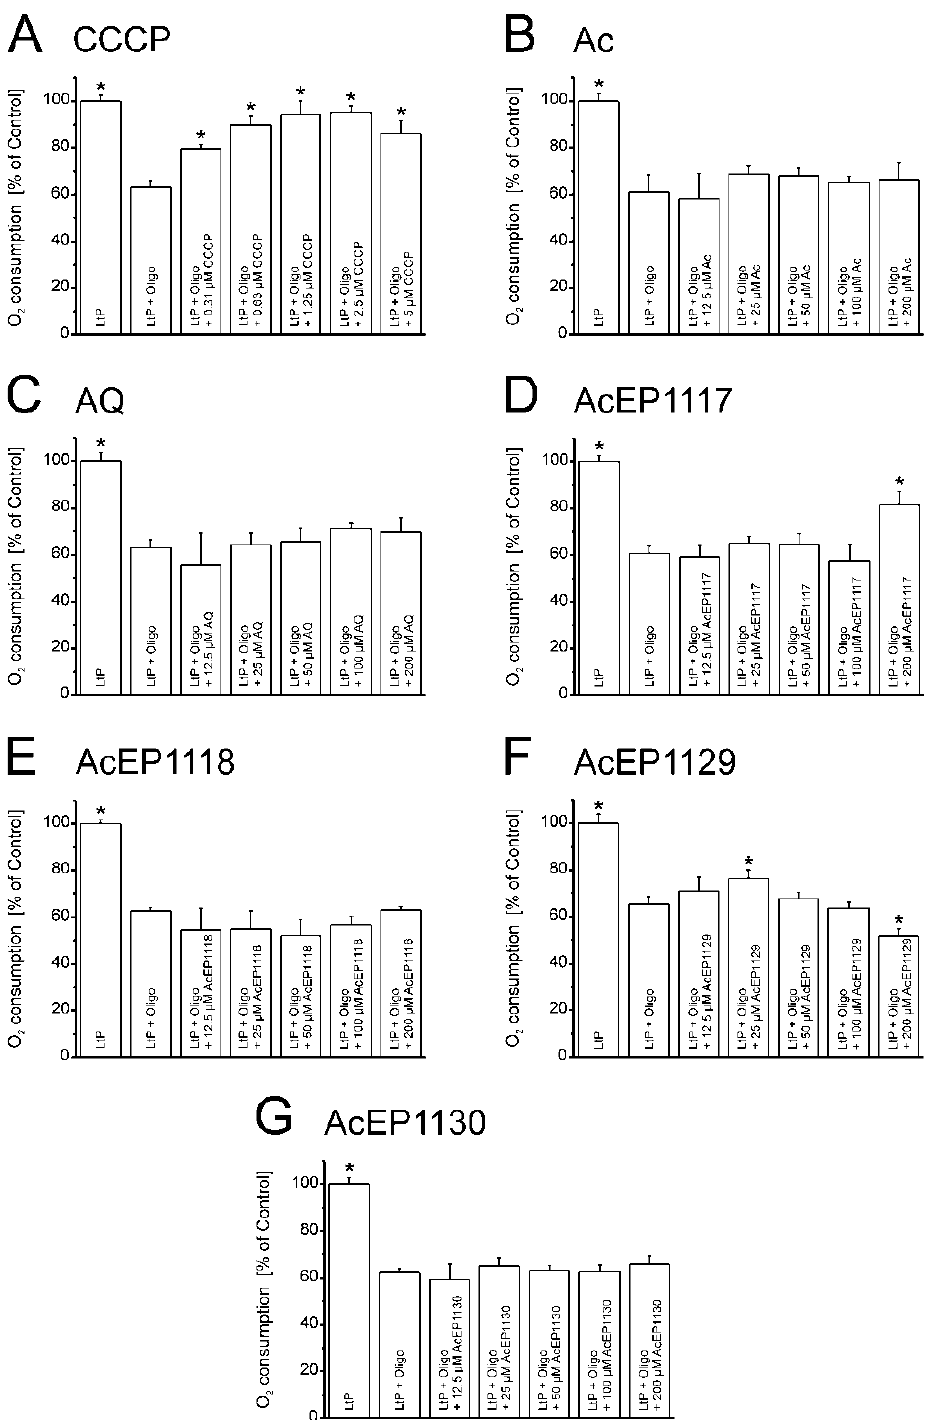
Figure 7. Influence of different anthracene derivatives on the oxygen consumption of LtP in the presence of the ATPase inhibitor oligomycin (Oligo, 38 µM). LtP (140 × 10 6 cells/mL) were treated with 0.31–5.0 µM CCCP ( A ) or 12.5–200.0 µM of Ac ( B ), AQ ( C ), AcEP1117 ( D ), AcEP1118 ( E ), AcEP1129 ( F ), AcEP1130 ( G ) (max. vehicle concentration 1.5% DMSO). Samples containing LtP in BHI medium with and without Oligo served as control. Measurements were carried out using OxoPlates over an incubation time of 40 min. Data were normalized against untreated cells (LtP, 100%). Data represent mean ± SD ( n = 3–4), * indicates significant differences to the control samples (LtP + Oligo) at the level of p < 0.05.